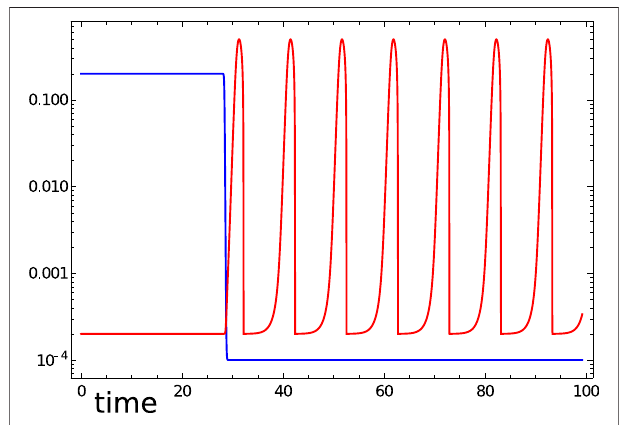
FIGURE 1 | Illumination ϕ j ( t ) (blue curve) and time evolution of u 1 ( t ) (red curve) in the time interval [0,99.3] predicted by Eqs 2 , 3 with the considered Oregonator parameters and t illum (1)=28.4.